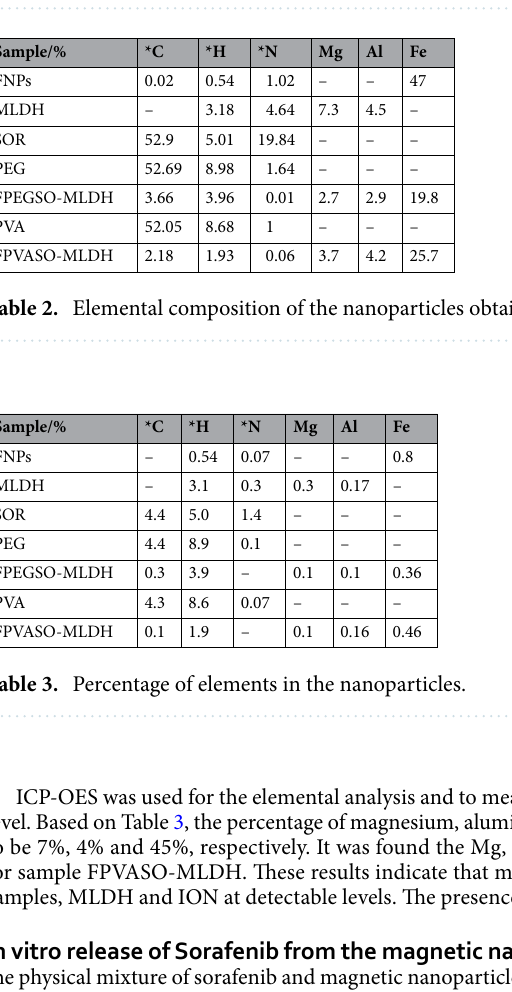
Figure 9. HPLC plot of ( A ) the nanoparticles co-coated with PEG; ( B ) the nanoparticles co-coated with PVA.